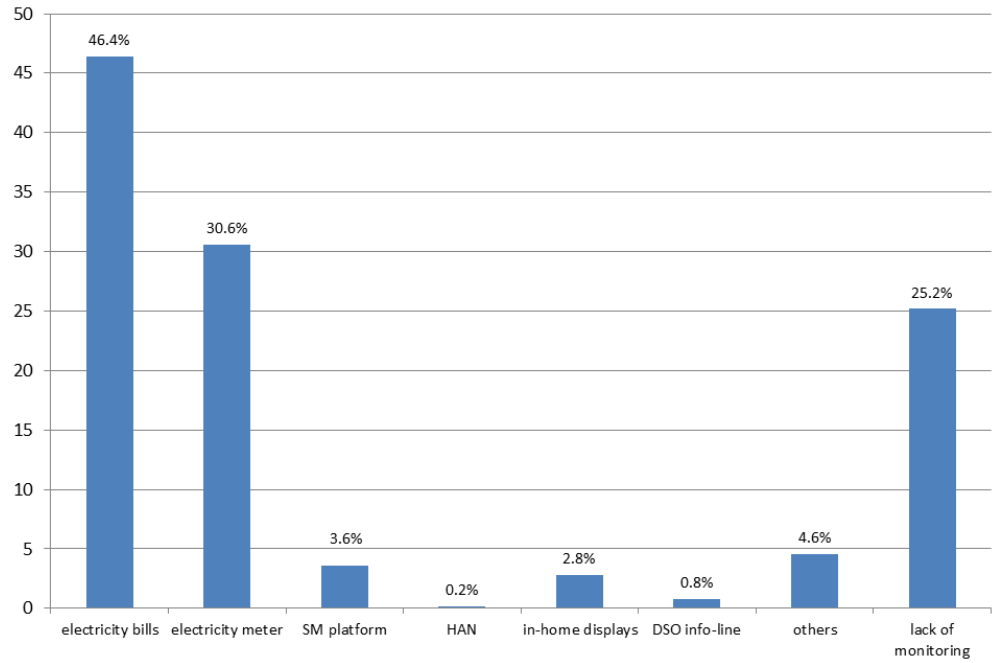
Figure 2. Respondents’ experience with energy monitoring (note: respondents were allowed to choose more than one